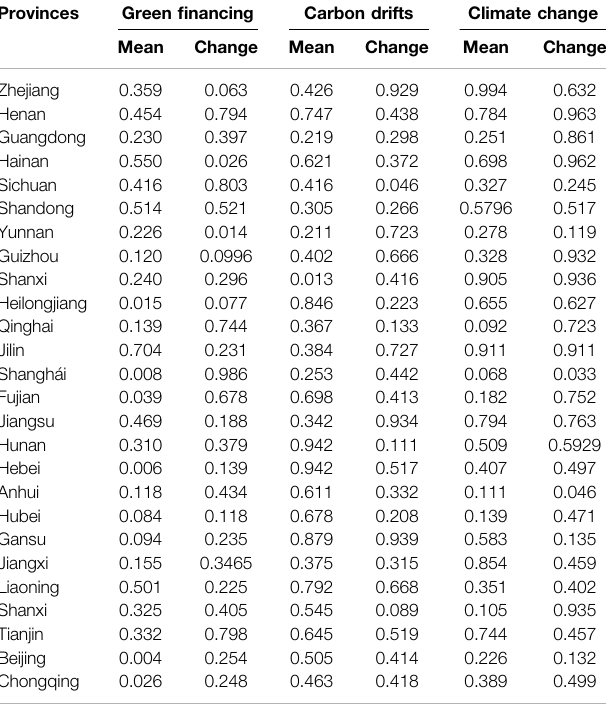
TABLE 3 | Percentage change in green fi nancing, carbon drifts and climate change mitigation and mean score. Provinces Green fi nancing Carbon drifts Climate change